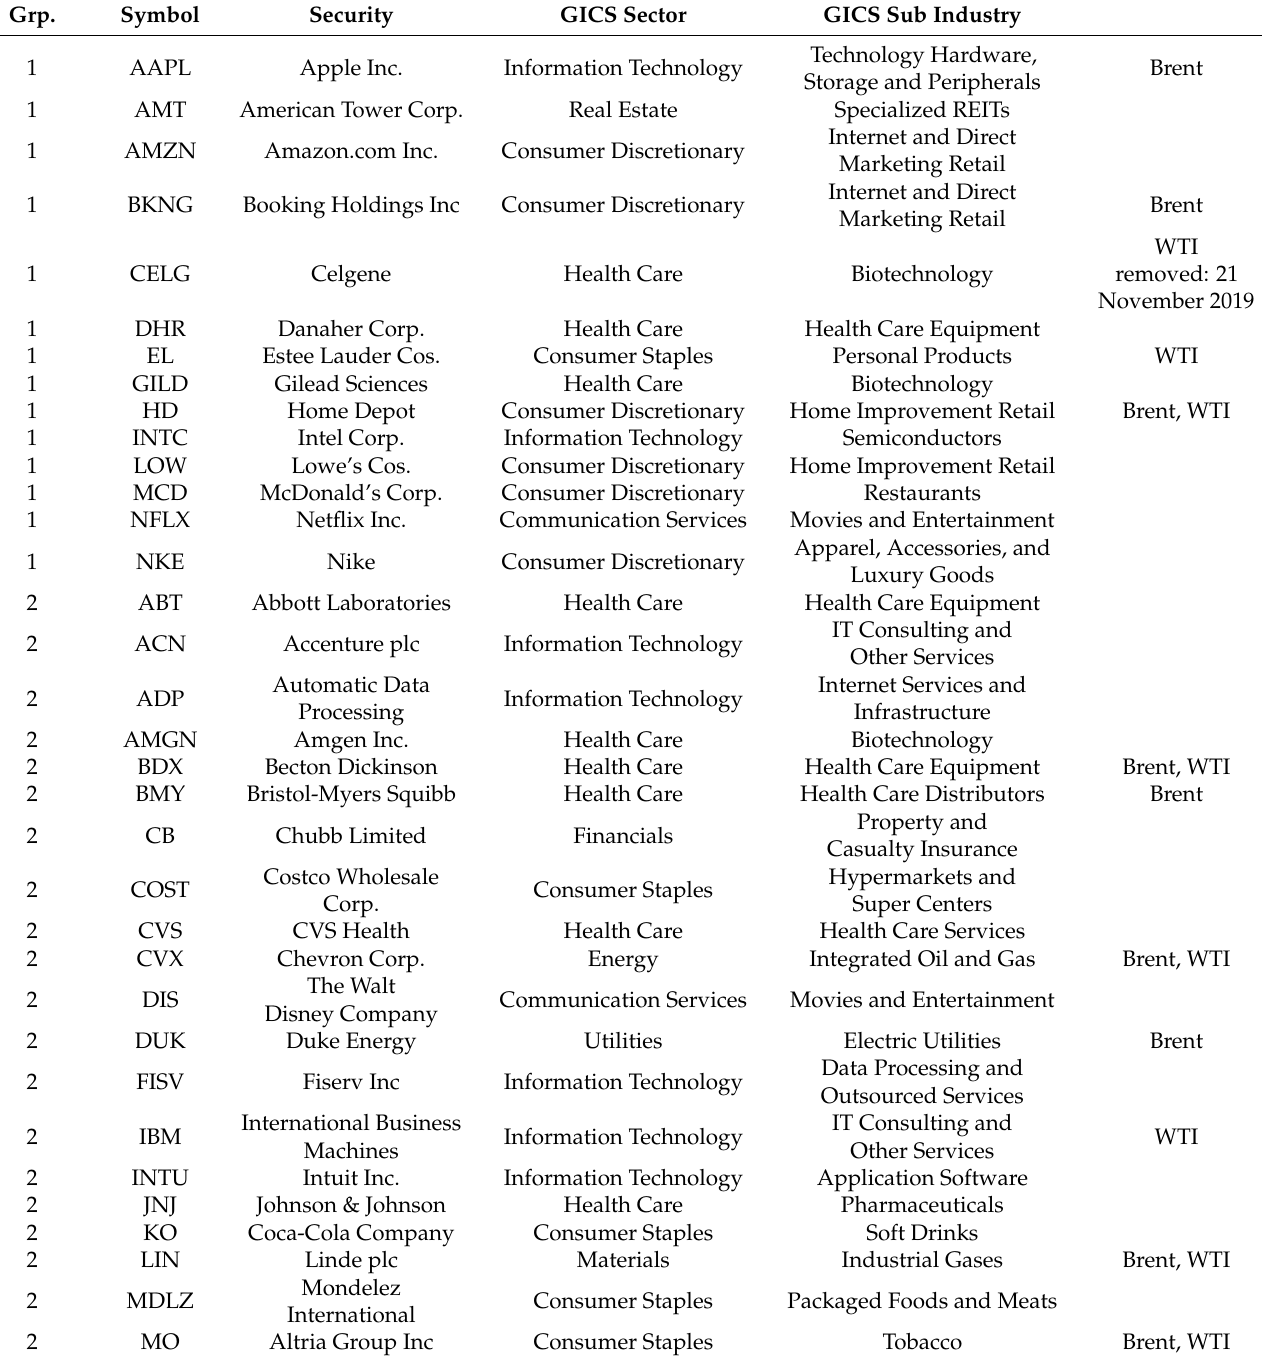
Table A2. Sector Information for